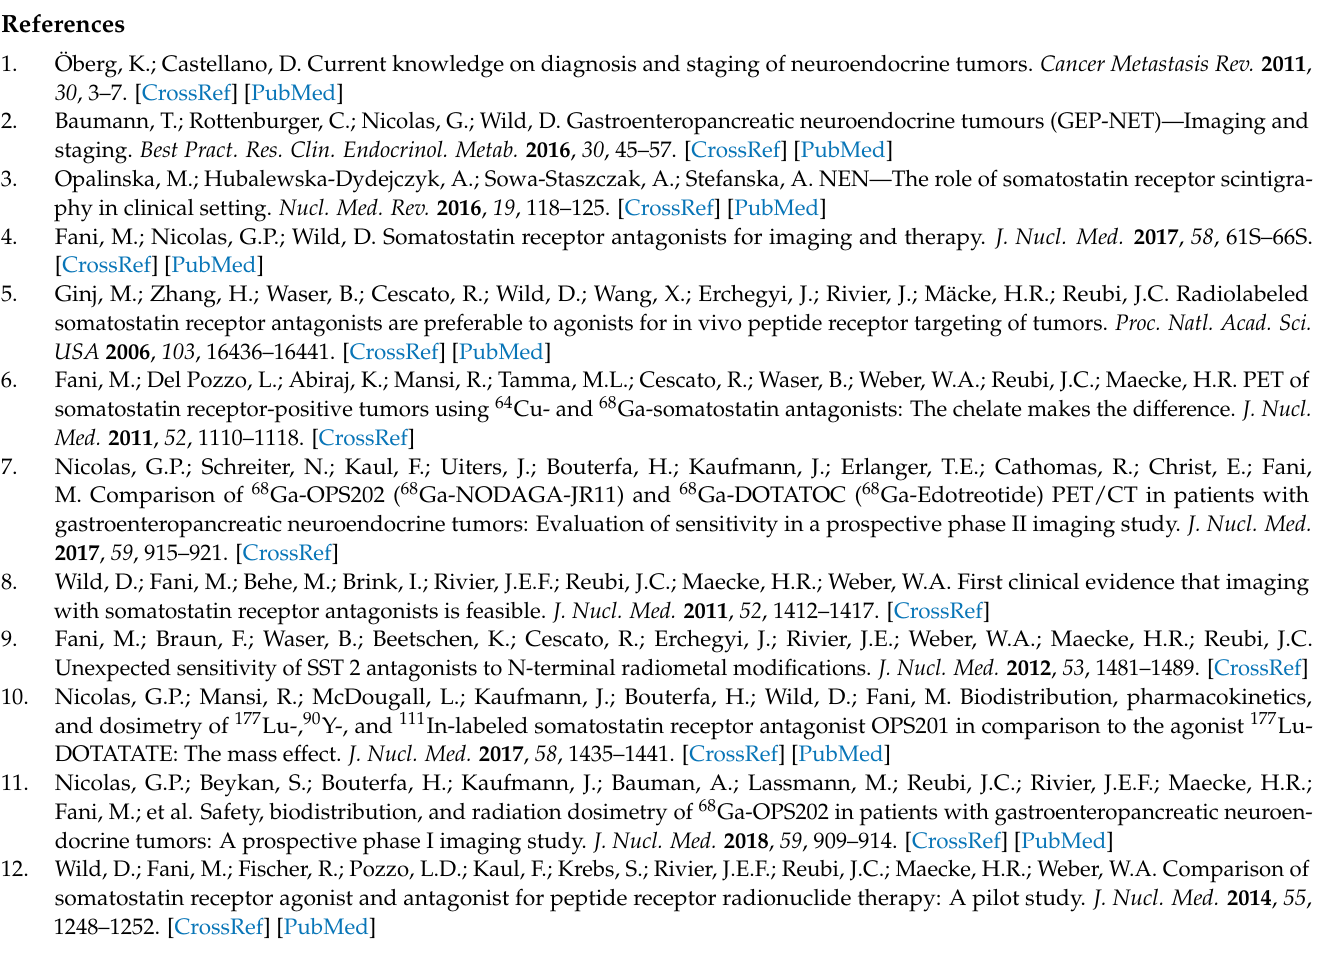
Figure A3. HPLC chromatogram of [ nat Re]Re-, [ 99m Tc]Tc- and unlabelled TECANT-2 (confirmative MS data available on request).